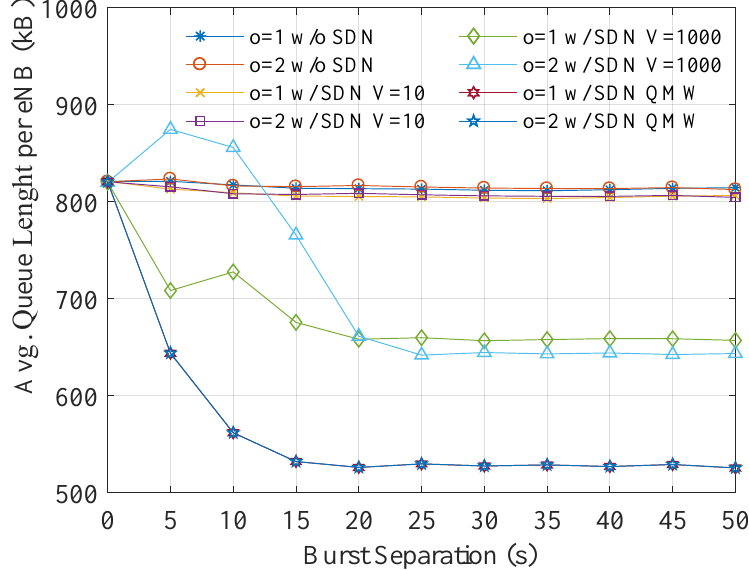
Figure 5. Queue length in kB at an eNB averaged over time and over the eNBs at a given operator o as a function of separation of o = 1 and o = 2 data bursts in s; Figures 3 and 4 consider a burst separation of 40